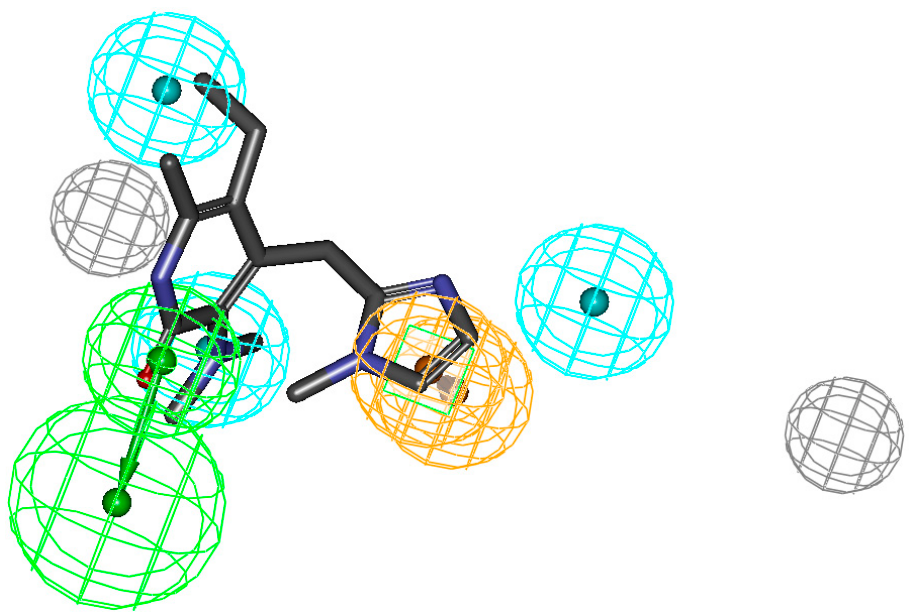
Figure 4. Pharmacophore mapping of the least active compound ( 83 ) from the training set, predicted correctly. Figure indicates the miss of one hydrophobic group essential for receptor binding. Reported activity: 100 µ M, estimated: 36 µ M, and fit value: